Question: Which kind of chart has been used to present this data?
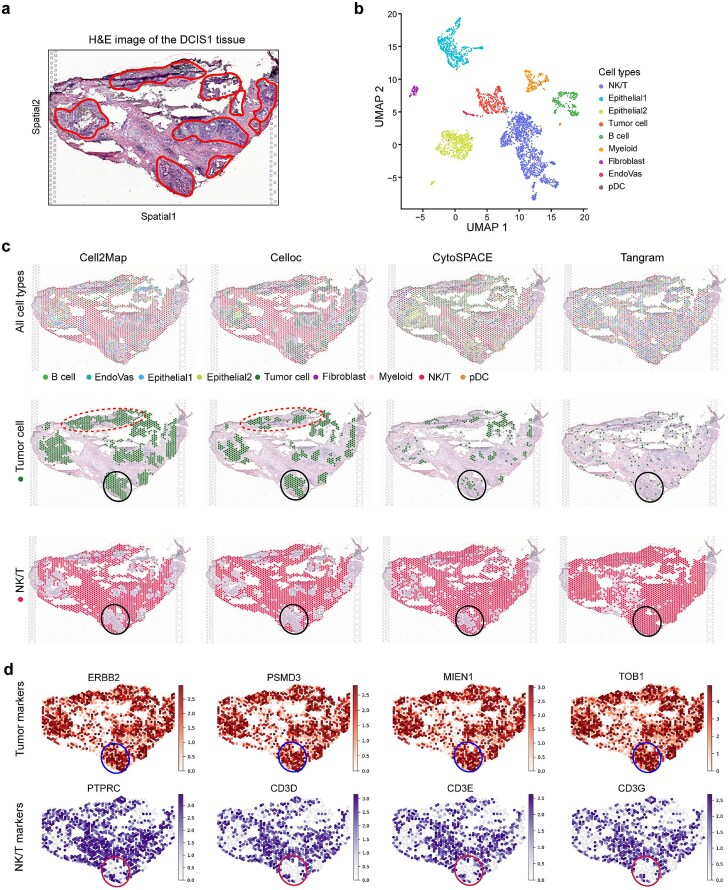
Answer: scatter